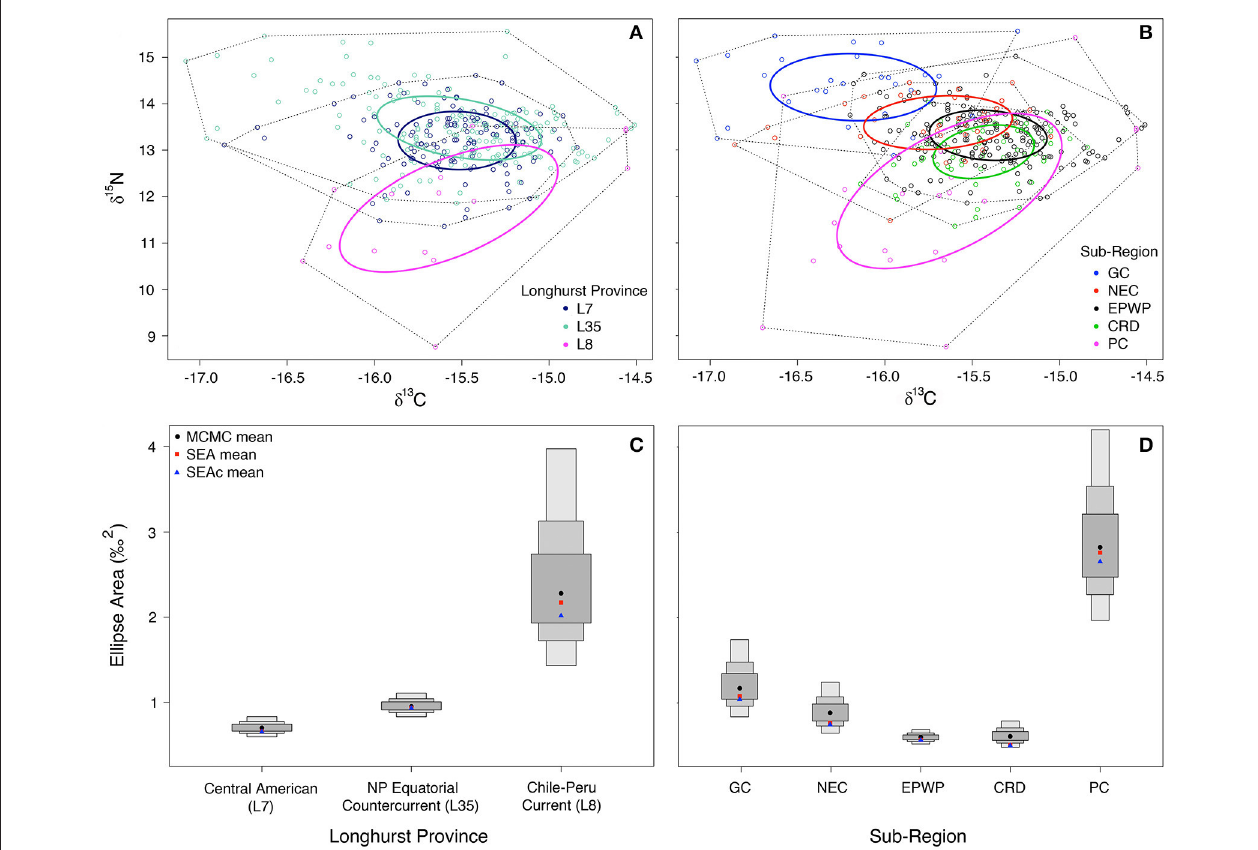
FIGURE 3 | Maximum likelihood standard ellipse area ( ‰ 2 ) estimation is plotted for (A) (L7) Central American ( n = 186), (L35) North Pacific Equatorial Countercurrent ( n = 137), and (L8) Chile-Peru Current ( n = 15) Longhurst provinces; and (B) Gulf of California ( n = 29), North Equatorial Current ( n = 36), East Pacific Warm Pool ( n = 192), and Costa Rica Dome ( n = 63) oceanographic sub-regions. Plotted in (C,D) are the Bayesian inference credible intervals (CI) around the Markov chain Monte Carlo (MCMC) ellipse area means, standard ellipse area (SEA) means, and the small sample size-corrected standard ellipse (SEAc) means (Parnell et al., 2010) for the Longhurst provinces and oceanographic sub-regions, respectively. The smallest/darkest gray box around the MCMC means (black circles) represents the 50% CI, and the next largest the 75% CI, and the largest the 95% CI.